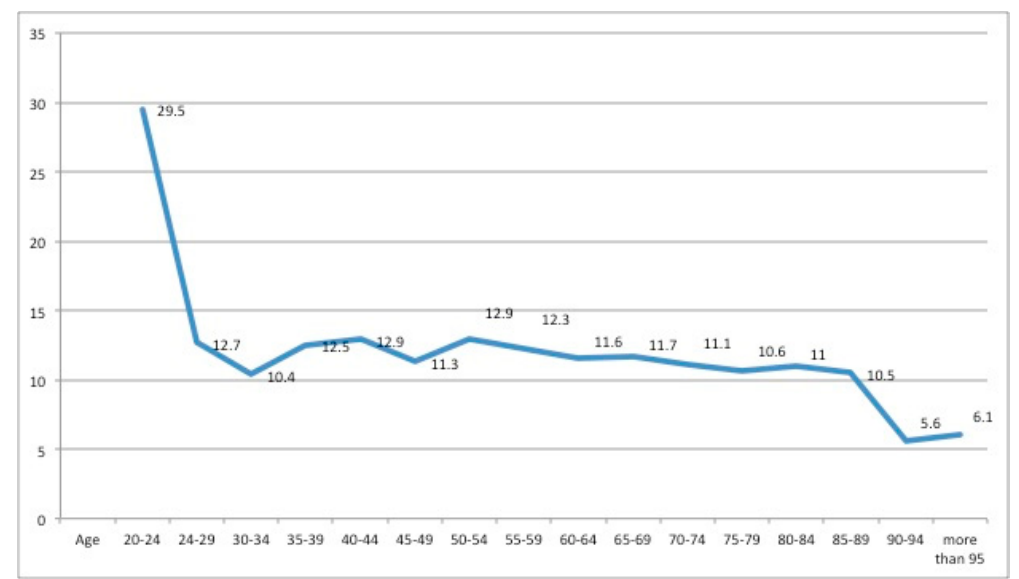
Figure 1. Average length of hospital stay (days), by age.